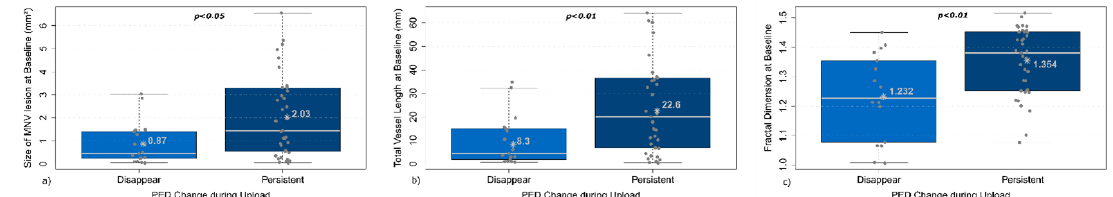
Figure 4. Boxplots showing the distribution of the area ( a ), total vascular length ( b ), and fractal dimension ( c ) of the MNV at the time of initial diagnosis in relation to the resolution or persistence of pigment epithelial detachment after three intravitreal injections of anti-VEGF. Each dot represents an individual measurement. The boxes enclose the measurements between the uppermost and lowermost quartiles. The whiskers show the last measurements within the 1.5-fold interquartile range. * = Mean, bar = median; Wilcoxon rank-sum